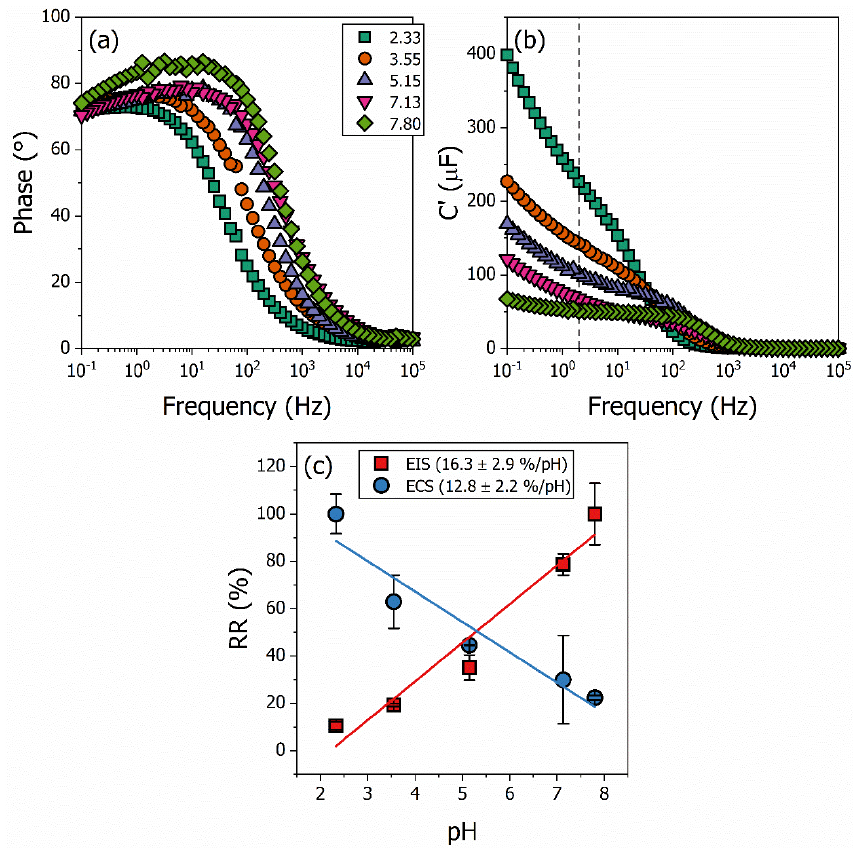
Figure 5. Electrochemical capacitance spectroscopy measurement analysis. The EIS phase angle vs. frequency in ( a ) and the capacitance data for the PANI/WO 3 nanocomposite for each pH buffer solution in ( b ). From the frequency of the maximum phase, 1.99 Hz, the relative response of the capacitance is obtained for each pH buffer solution. Calibration curves using the relative response of the electrochemical capacitance, C µ , and the charge-transfer resistance, R CT , are plotted as a function of the pH in ( c